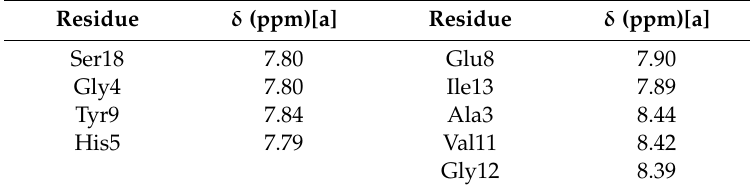
Table 2. 1H chemical shift of the amide protons of the new compound that underwent peak overlapping [a]. From the total correlated spectroscopy (TOCSY) spectrum in methanol-d 3 at 298